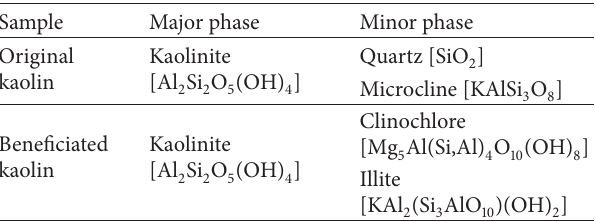
Table 2: Mineralogical composition of the raw materials.